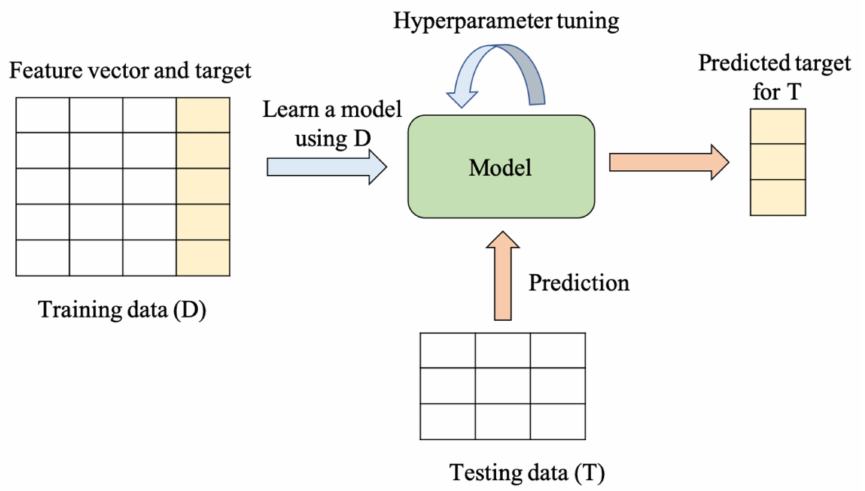
Figure 5. The general workflow of how supervised ML works is shown. Here, D and T represent training data and testing data,